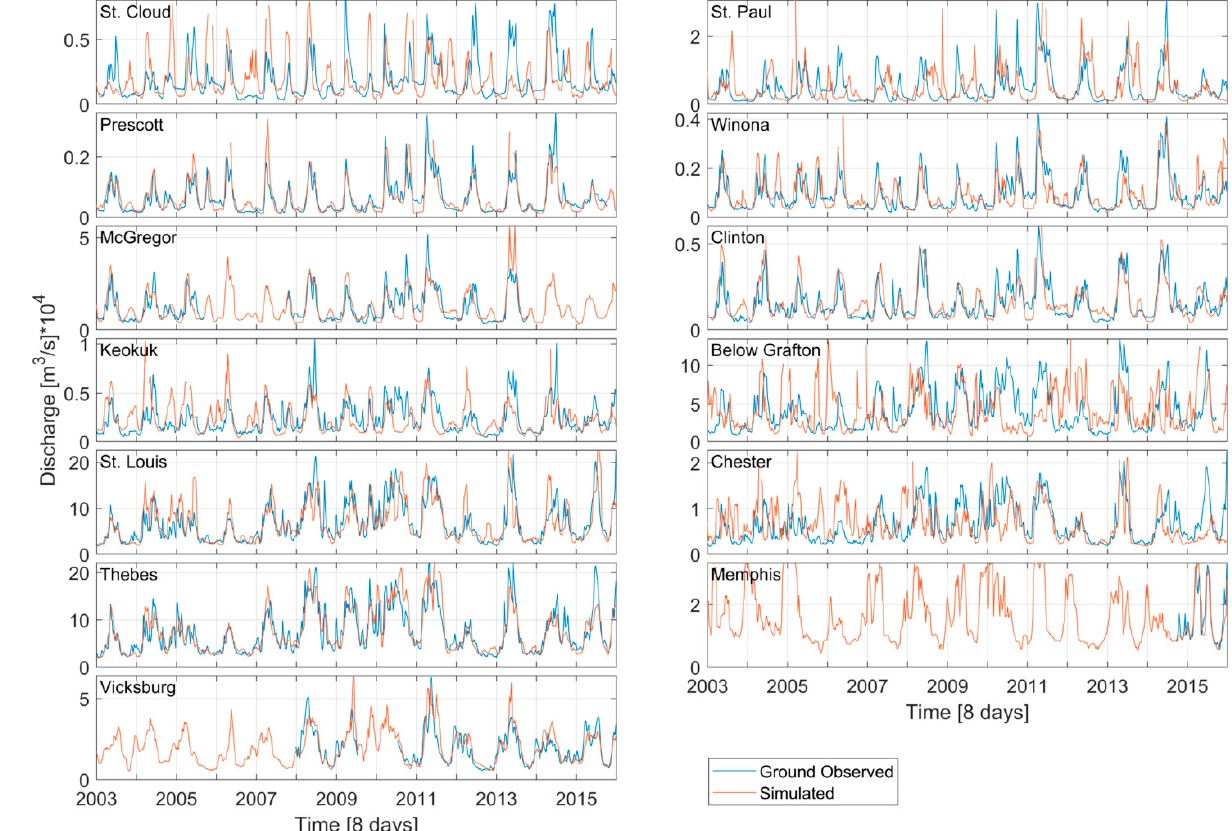
Figure 6. Calibration phase: Comparison between the observed and simulated discharges. Table 2. Calibration phase: Performance indices of the comparison between the observed and simulated discharges: Pearson correlation coefficient, R p , Spearman correlation coefficient, R s ,